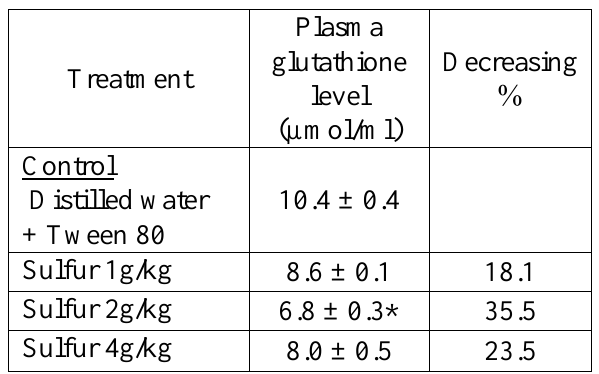
Table 3: Sulfur effects on the plasma glutathione level in mice.